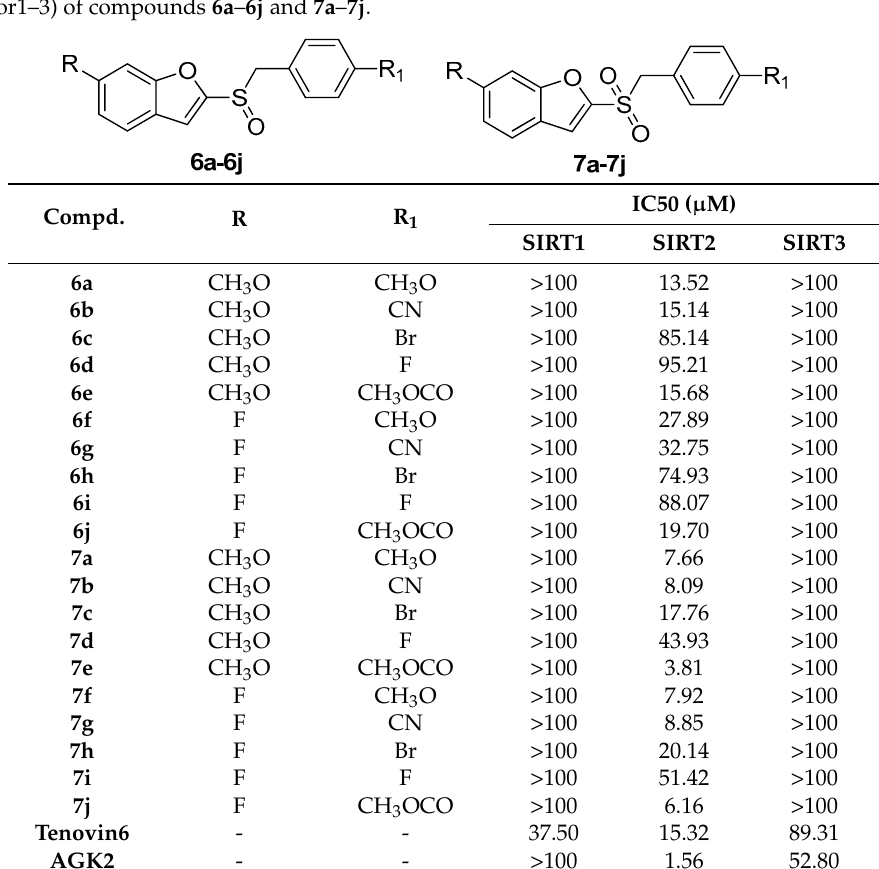
Scheme 1. Synthesis of compounds 6a – 6j and 7a – 7j. Reagents and conditions: A ethoxycarbonylhydrazine, concentrated HCl, ethanol, 80 °C; b SOCl 2 , CHCl 3 and DMF ( N , N -Dimethylformamide); c K 2 CO 3 , Molecules 2017 , 22 , 1348 Table 1. The chemical structures and inhibitory activities against SIRT1–3 (silent information regulator1–3) of compounds 6a – 6j and 7a – 7j .